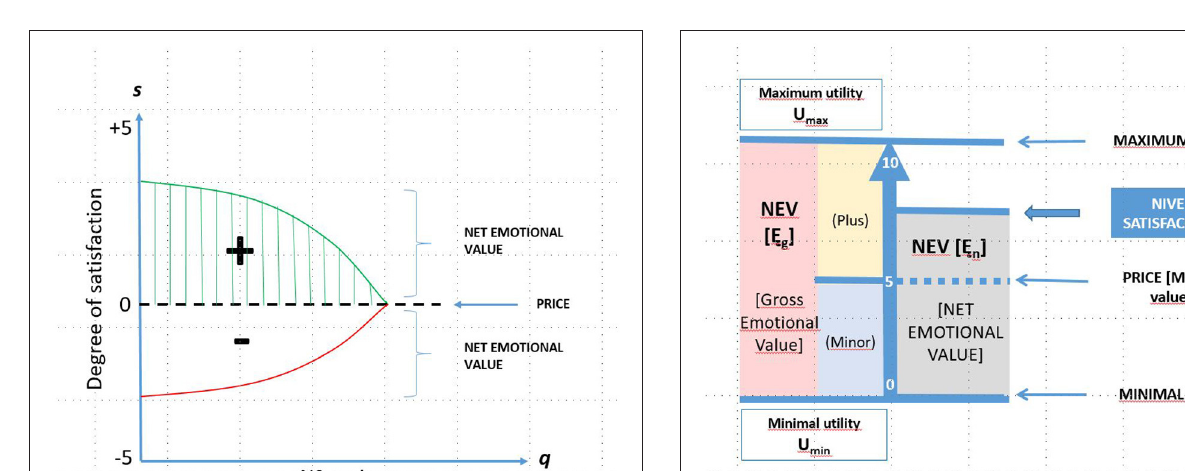
maximum willingness to pay multiplied by the number of units.